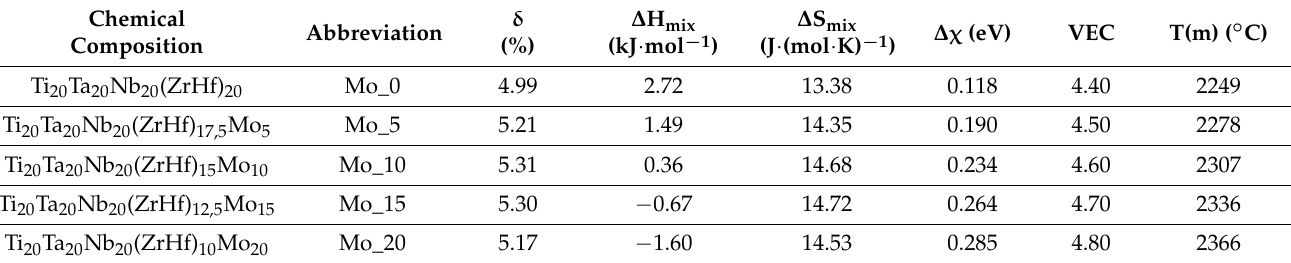
Table 2. Thermodynamic parameters calculated for the studied high entropy alloys: Atomic